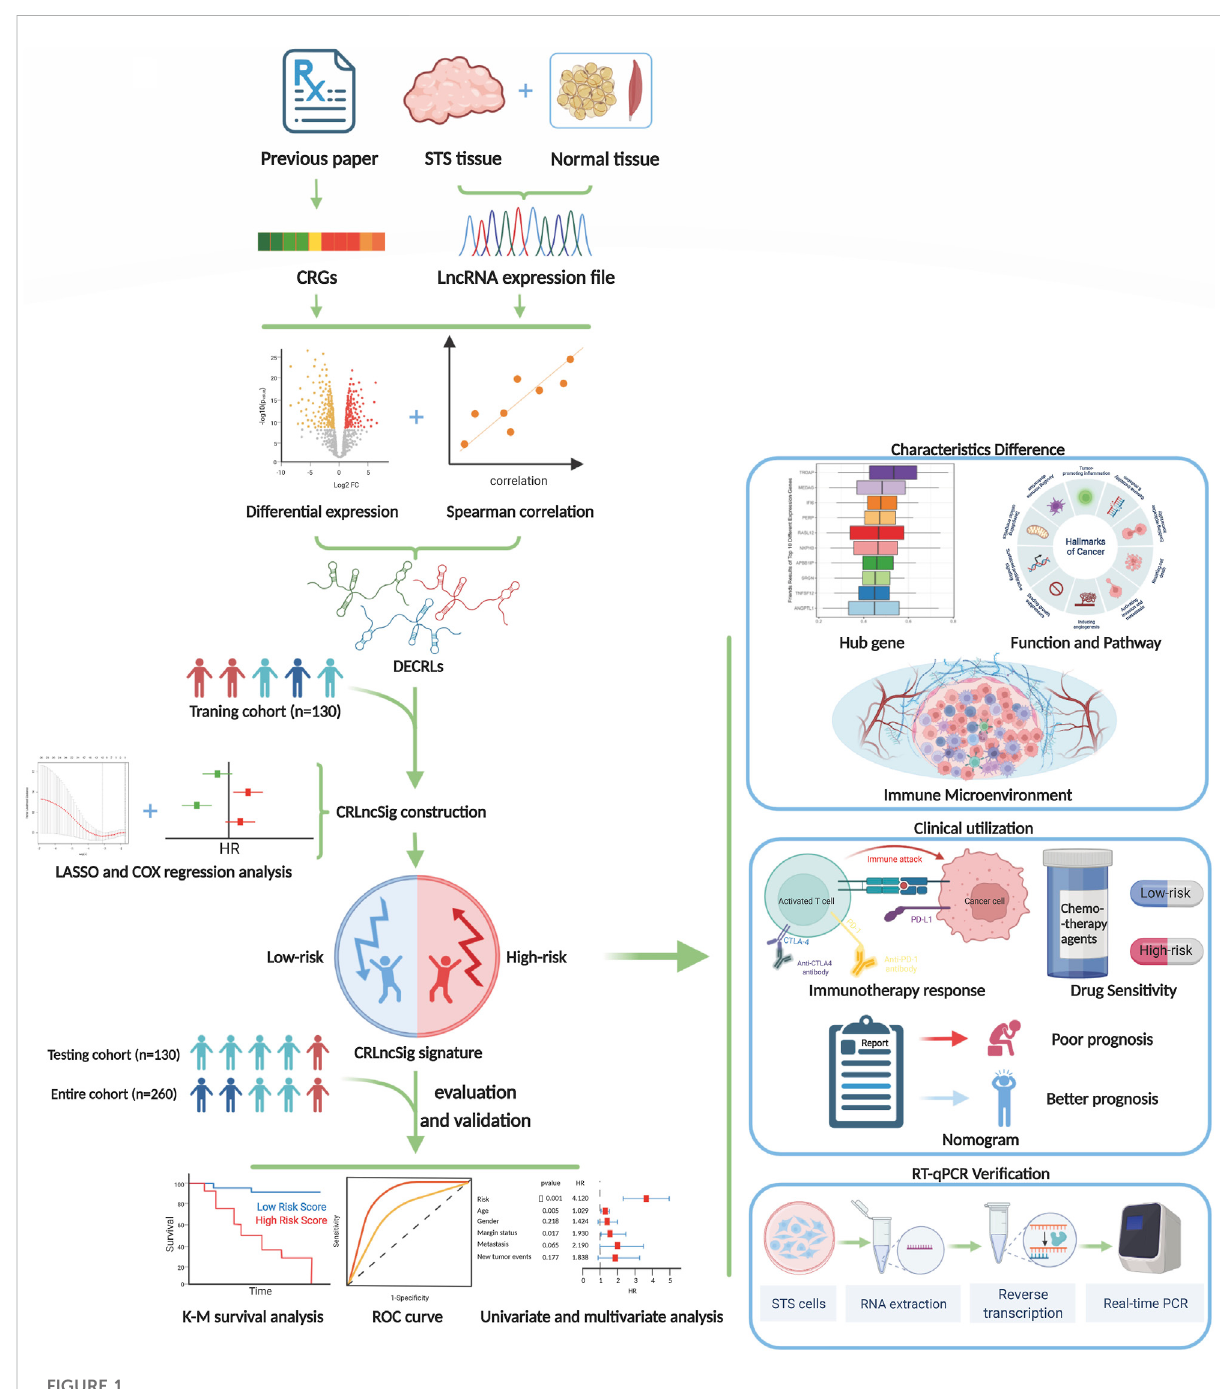
FIGURE 1 The fl ow diagram of our